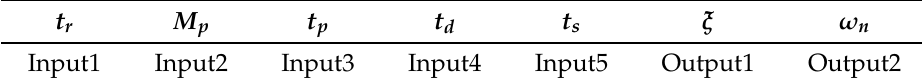
Table 2. Variables of the database and its use in the